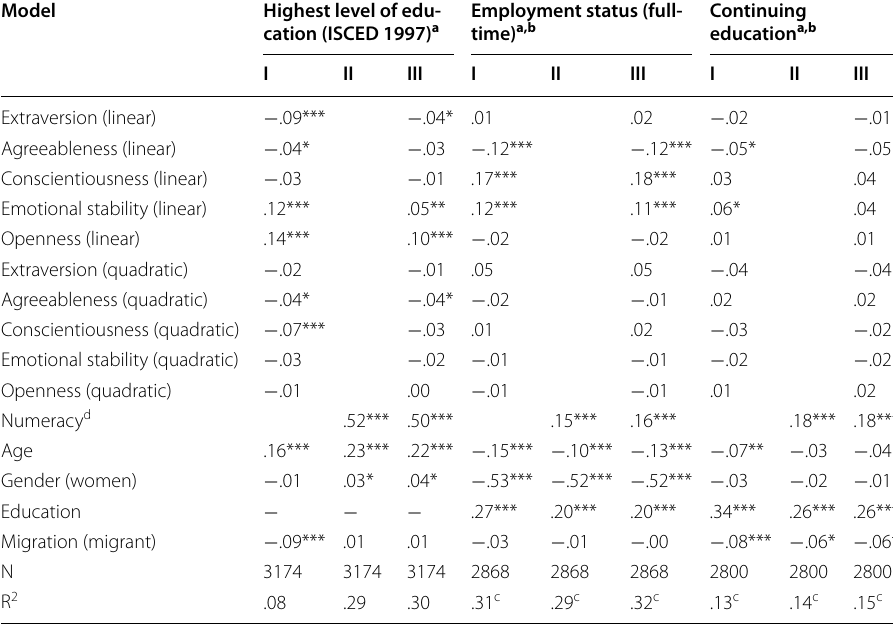
Table 2 Relationships between personality, numeracy, and important life